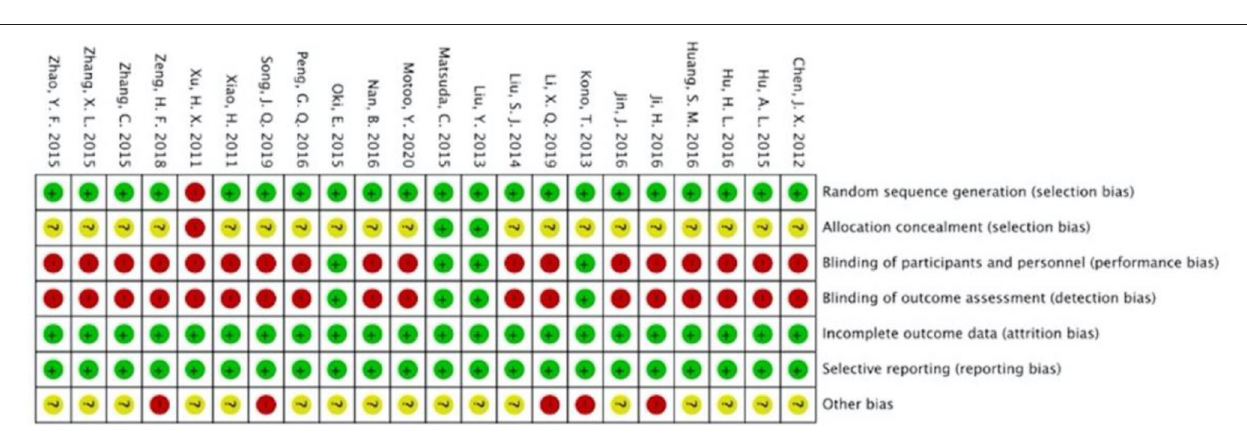
FIGURE 3 | Risk of bias assessment by individual